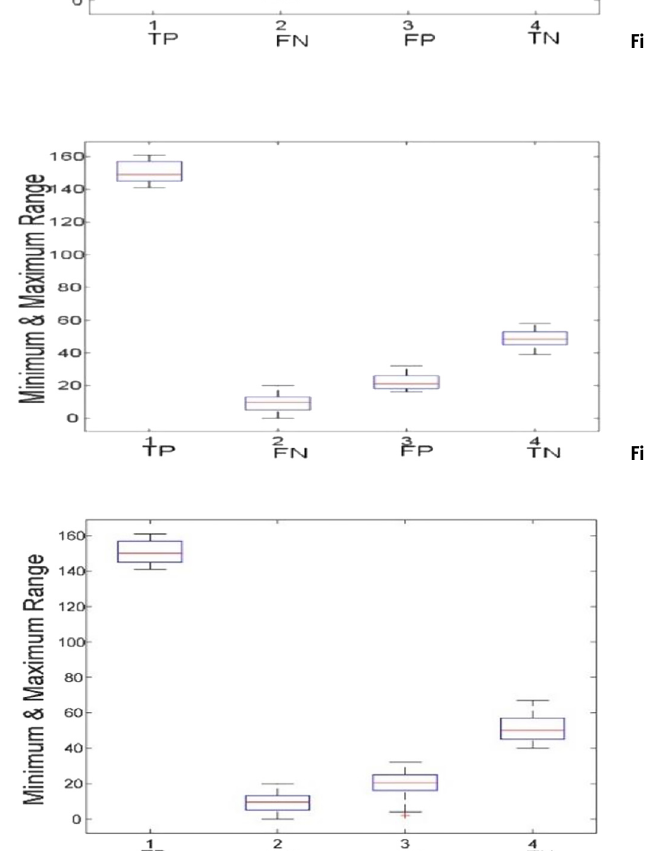
Figure 17: Boxplot (CJaya-ELM).